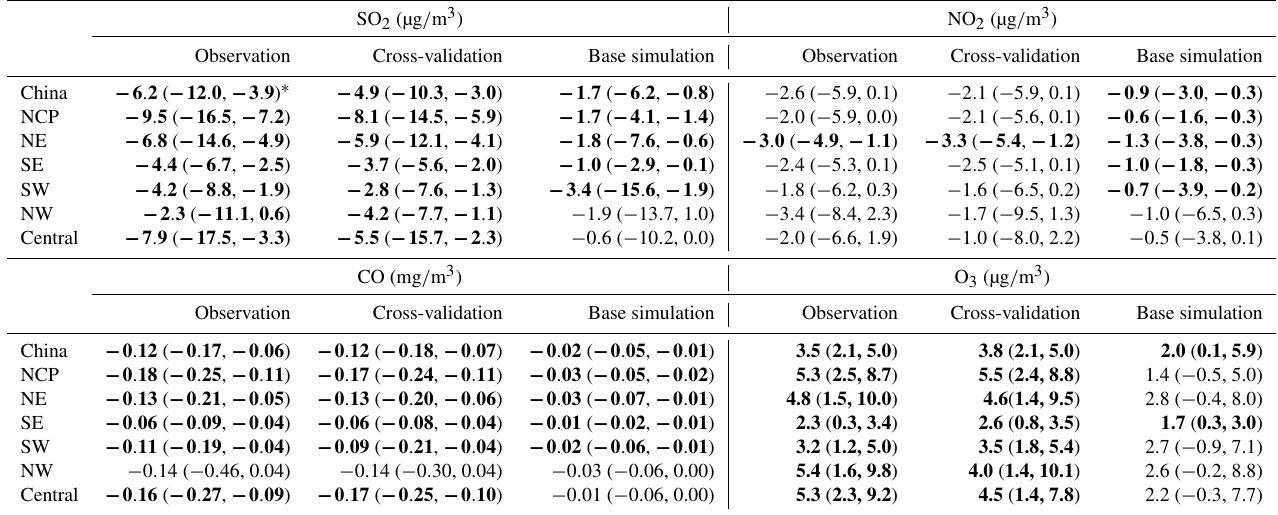
Table 6. Calculated annual trends of the SO 2 , NO 2 , CO, and O 3 concentrations in